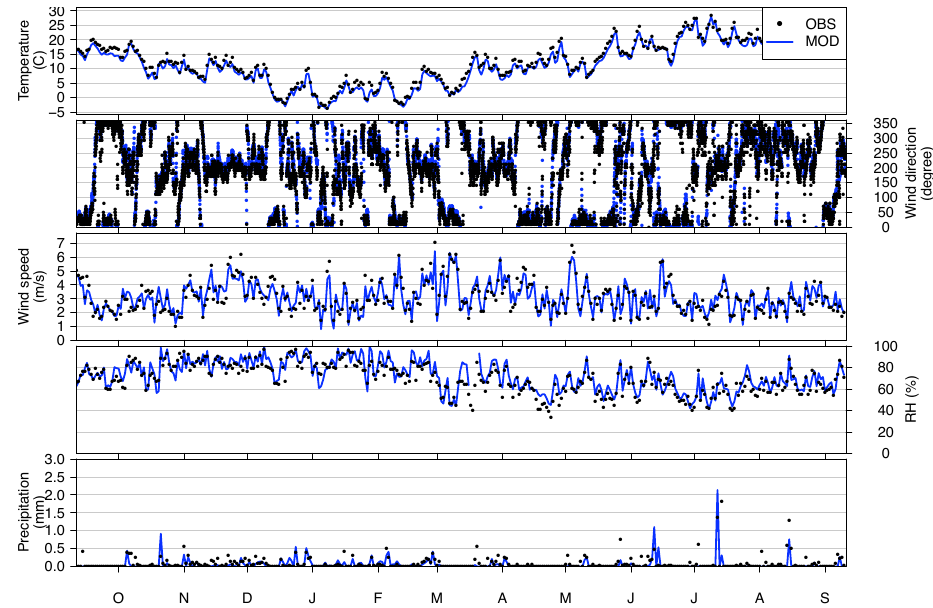
Figure 4. Measured and simulated meteorological parameters at the MONTSOURIS station (in the center of Paris). Temperature, wind speed, relative humidity (RH) and precipitations are reported as daily values while wind direction has a 1h time resolution. Table 4. Statistical results for meteorological parameters simulation. Paris, MONTSOURIS site MB